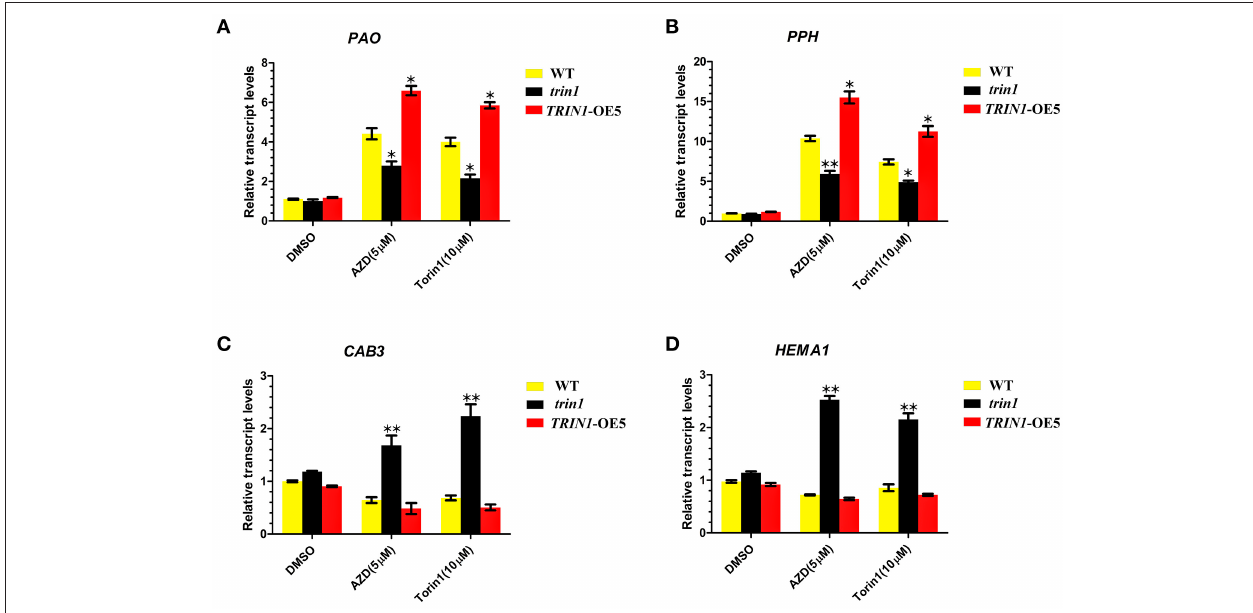
FIGURE 5 | TOR regulates transcription of genes related to chlorophyll synthesis and decomposition. (A–D) qRT-PCR analysis of PAO , PPH , CAB3, and HEMA1 transcripts in 10- day-old WT, trin1, and TRIN1 -OE5 plants treated with DMSO, AZD (5 µ M), and Torin1 (10 µ M) for 36h. The data represents the mean ± SD of n = 3 independent experiments. Asterisks denote Student’s t -test significant difference compared with WT plants ( * P < 0.05 ; ** P < 0.01